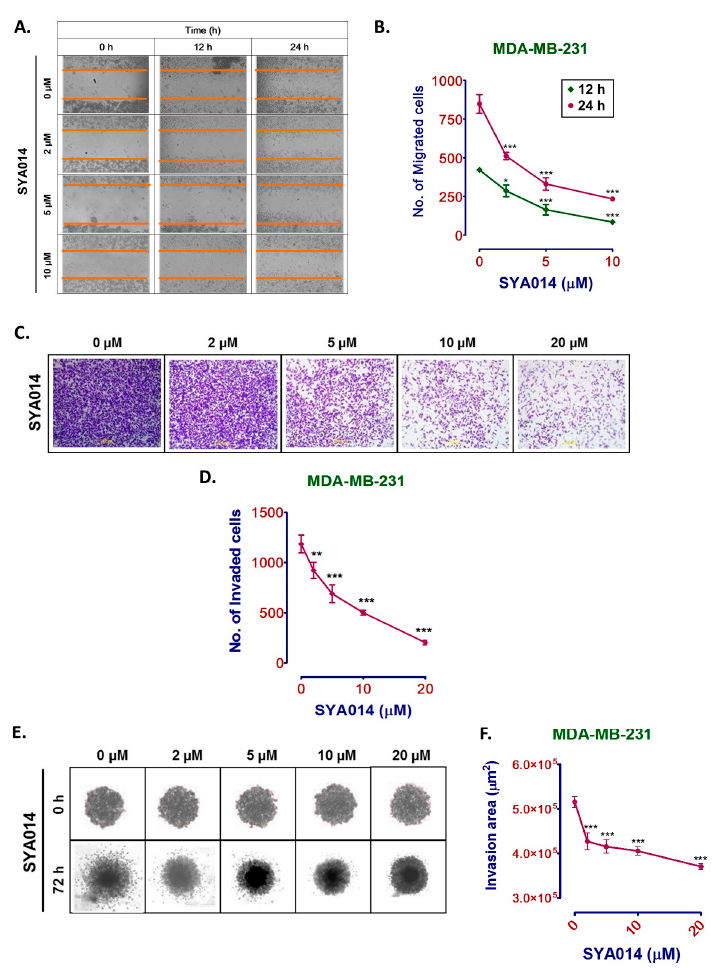
Figure 4. SYA014 inhibits the migration and invasion of MDA-MB-231 cells. MDA-MB-231 cells treated with SYA014 for 48 h inhibit cell migration ( A ) and reduce the number of migrated cells ( B ). The inhibitory effect of SYA014 on MDA-MB-231 cell invasion in the 2D single cell assay ( C , D ) and the 3D spheroid invasion assay ( E , F ) were determined. Representative images of the crystal violet stained cells after treatment with SYA014 in the 2D invasion assay, and quantification of the invaded cells, are shown in ( C , D ), respectively. Representative bright field microscopic images of 3D Spheroid invasion assay and the quantification of the invaded area through the Matrigel compared to the control are shown in E and F , respectively. Each point represents the mean ± SEM of four determinations. * p < 0.05, ** p < 0.01, and *** p < 0.001 vs. control cells were compared by one-way ANOVA analysis followed by the Dunnett’s multiple comparison